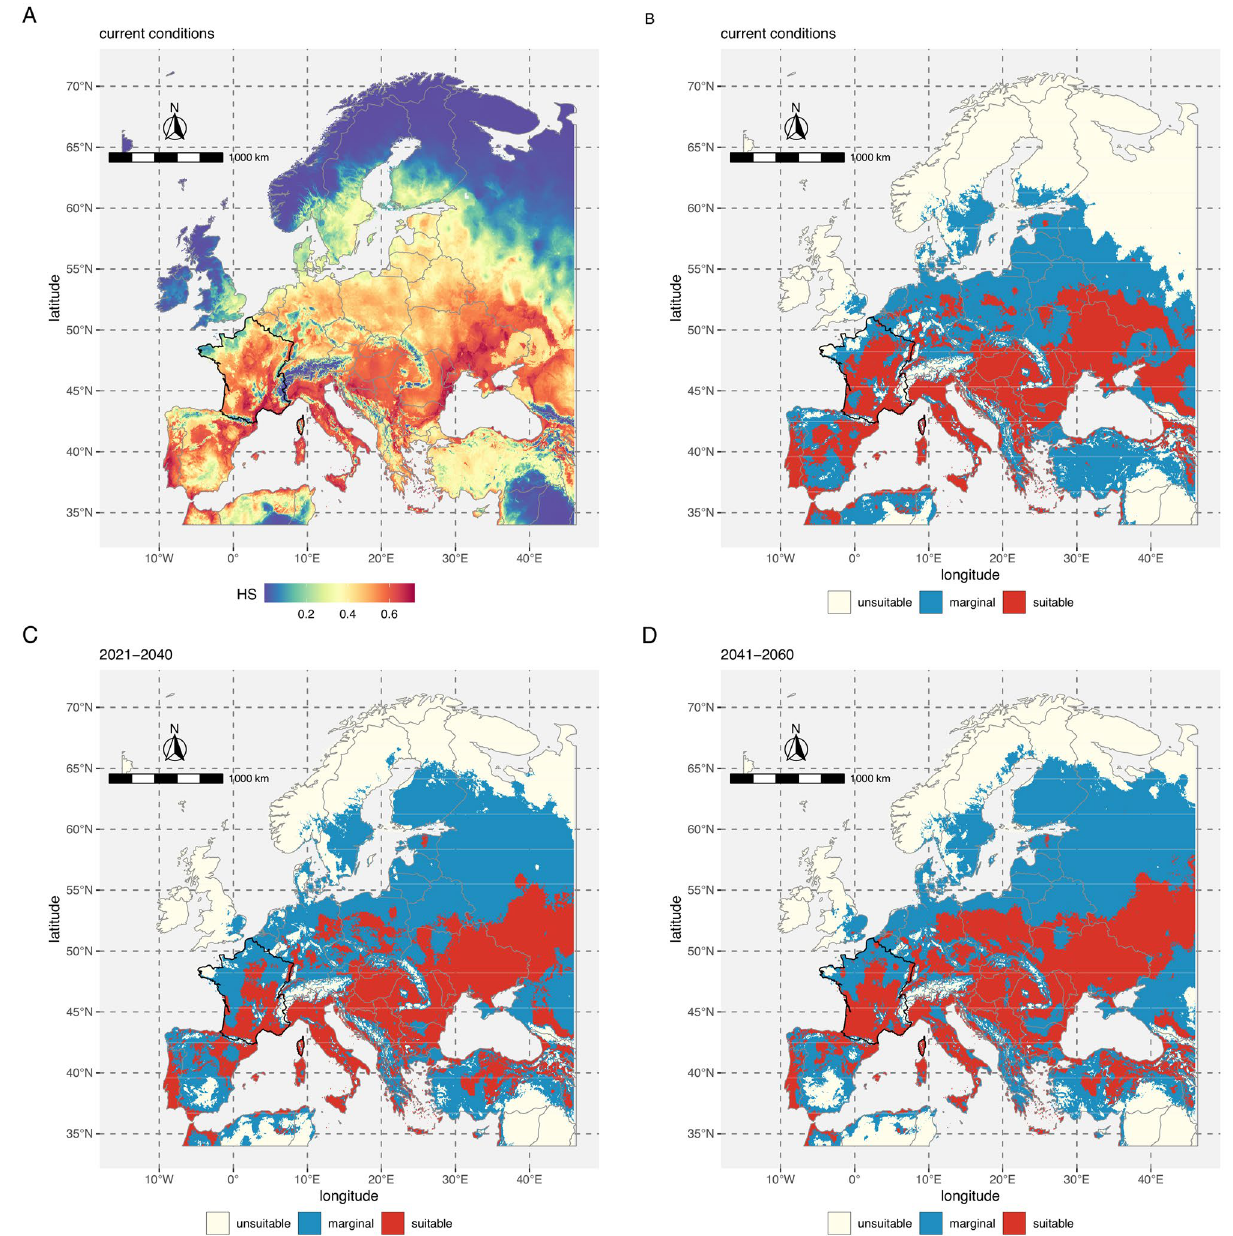
Figure 4. Potential geographical distribution of the brown marmorated stinkbug H. halys . ( A ) Climate suitability estimated by a maxent model according to current climate conditions. ( B ) Reclassified climate suitability according to current climate conditions. ( C ) Reclassified climate suitability for the period 2021– 2040. The underlying climate suitability is a consensus derived for the projections of the model with 6 global circulation models. ( D ) Reclassified climate suitability for the period 2041–2060. The underlying climate suitability is a consensus derived for the projections of the model with 6 global circulation models and the shared socio-economic pathways SSP245. The maps were generated using R 4.0.3 (https:// cran.r- proje ct.